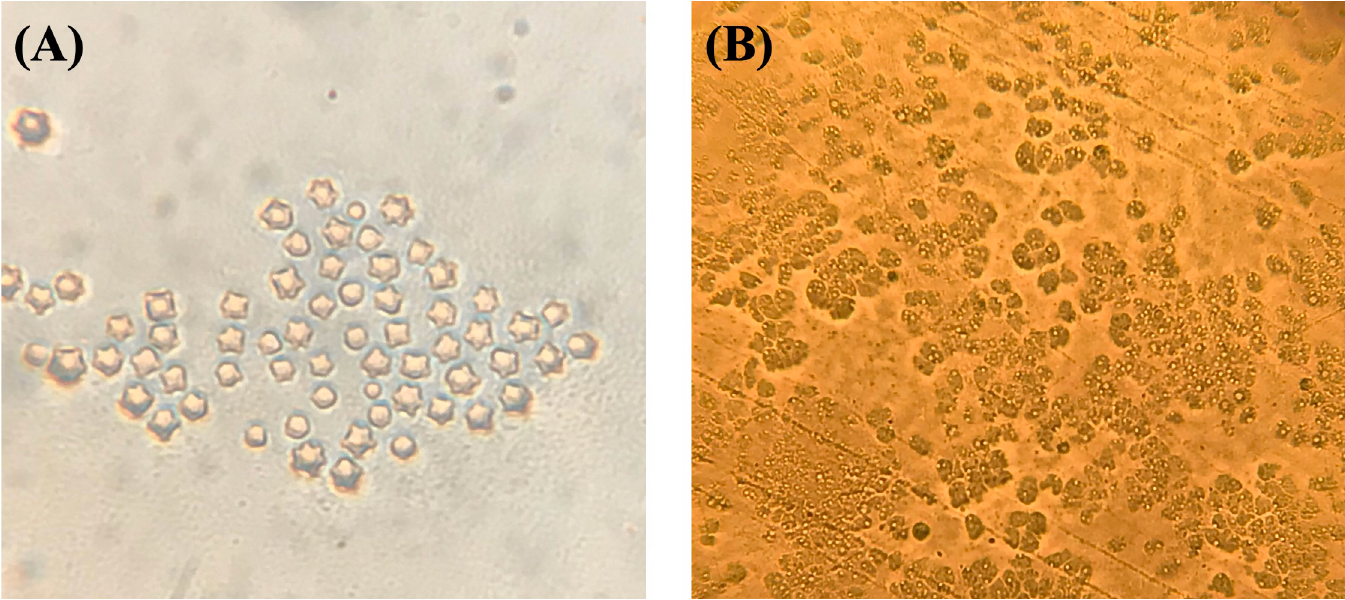
Fig 1. Acanthamoeba cysts and trophozoites in non-nutrient agar plate found in various water sources collected from in İ zmir, Turkey. A) Acanthamoeba cysts, B) Acanthamoeba